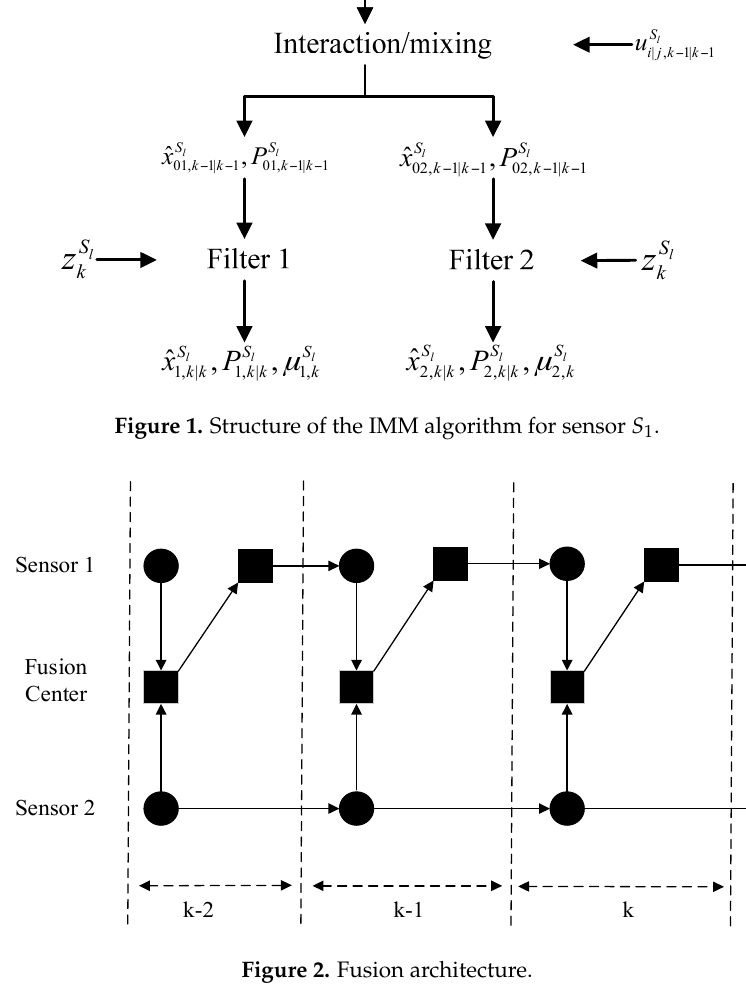
Figure 2. Fusion Figure 2. Fusion architecture. Figure 2. Fusion architecture.